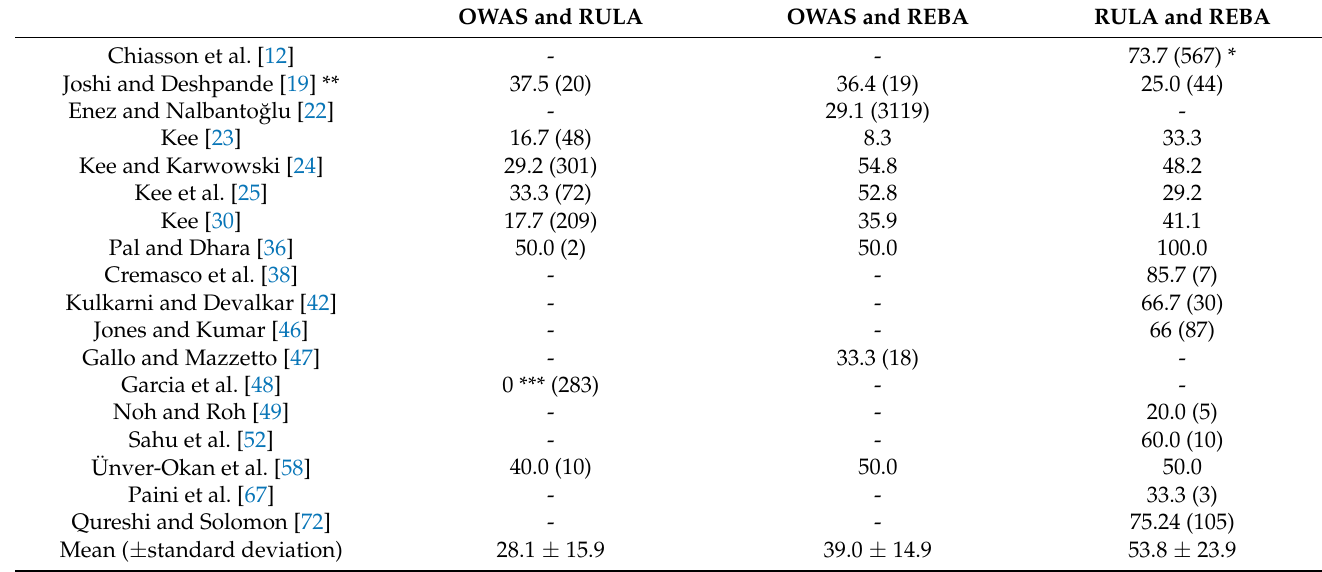
Table 3. Agreements between methods (%).